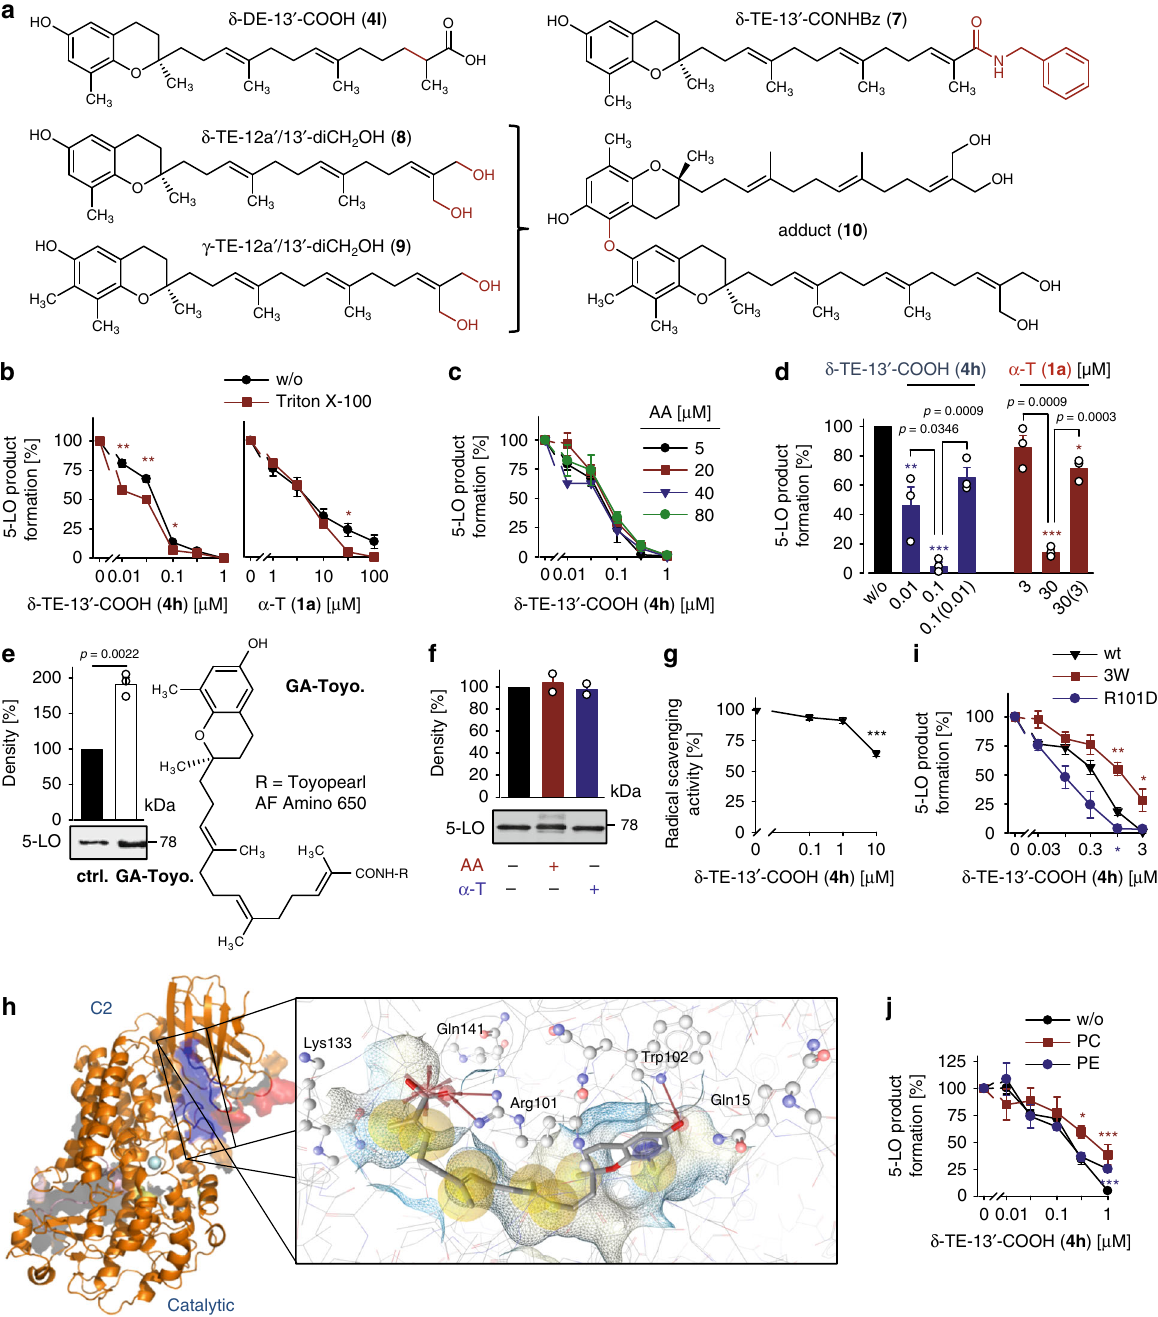
Fig. 1 Molecular insights into 5-LO inhibition by LCMs. a Structures of LCMs. b , c Effect of Triton X-100 (0.01%, c ) and of the substrate concentration (AA, c ) on 5-LO inhibition by δ -TE-13 ′ -COOH ( 4h ) or α -T ( 1a ). d Reversibility of 5-LO inhibition by δ -TE-13 ′ -COOH ( 4h ) and α -T ( 1a ). Samples were pre- incubated with vehicle or compound for 15 min, 10-fold diluted and incubated for another 5 min before AA was added. Numbers in brackets indicate the diluted compound concentration after pre-incubation. e , f 5-LO pull-down by immobilized δ -TE-13 ′ -COOH ( 4h ; GA-Toyo) or immobilized 4-phenoxy butyric acid (ctrl.), which resembles a truncated form of δ -TE-13 ′ -COOH ( 4h ), in the presence of AA or α -T ( 1a ; 100 µ M, each, f ). g Scavenging of DPPH radicals by δ -TE-13 ′ -COOH ( 4h ). h Molecular docking simulations of 5-LO showing the interaction of δ -TE-13 ′ -COOH ( 4h ) with Arg101 and Trp102 at the interface of the catalytic and regulatory C2-like domains. i Effect of δ -TE-13 ′ -COOH ( 4h ) on the inhibition of 5-LO product formation by HEK-293 cells that stably express either wild-type 5-LO (wt), triple 5-LO mutant Trp13Ala, Trp75Ala, and Trp102Ala (3 W) or Arg101Asp 5-LO. j Inhibition of puri fi ed 5-LO by δ -TE-13 ′ -COOH ( 4h ) in the presence of phosphatidylcholine (PC) or phosphatidylethanolamine (PE; 100 µ g/ml, each). Mean ± s.e.m. ( b , c , g , i , j ) and single data ( d – f ) from n = 3 ( b – e , g , i , j ), n = 2 ( f ) independent experiments. * P < 0.05, ** P < 0.01, *** P < 0.001 vs. absence of Triton X-100 ( b ), 20 µ M AA ( c ), vehicle/control ( d – g ), wt 5-LO ( i ) or absence of phospholipids ( j ); two-tailed paired Student t test ( b – e , i , j ) or repeated measures one-way ANOVA + Tukey HSD post hoc tests ( d , f , g